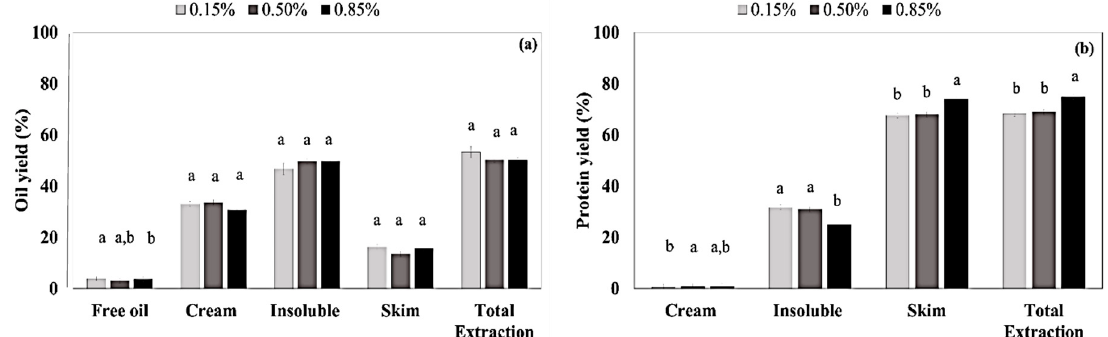
Figure 4. Experimental validation of the EAEP conditions (1:12.82 SLR and 0.15%, 0.50%, and 0.85% enzyme (wt/wt of almond cake): oil ( a ) and protein ( b ) extraction yields. Means within the same fraction with different letters are statistically different at p < 0.05.